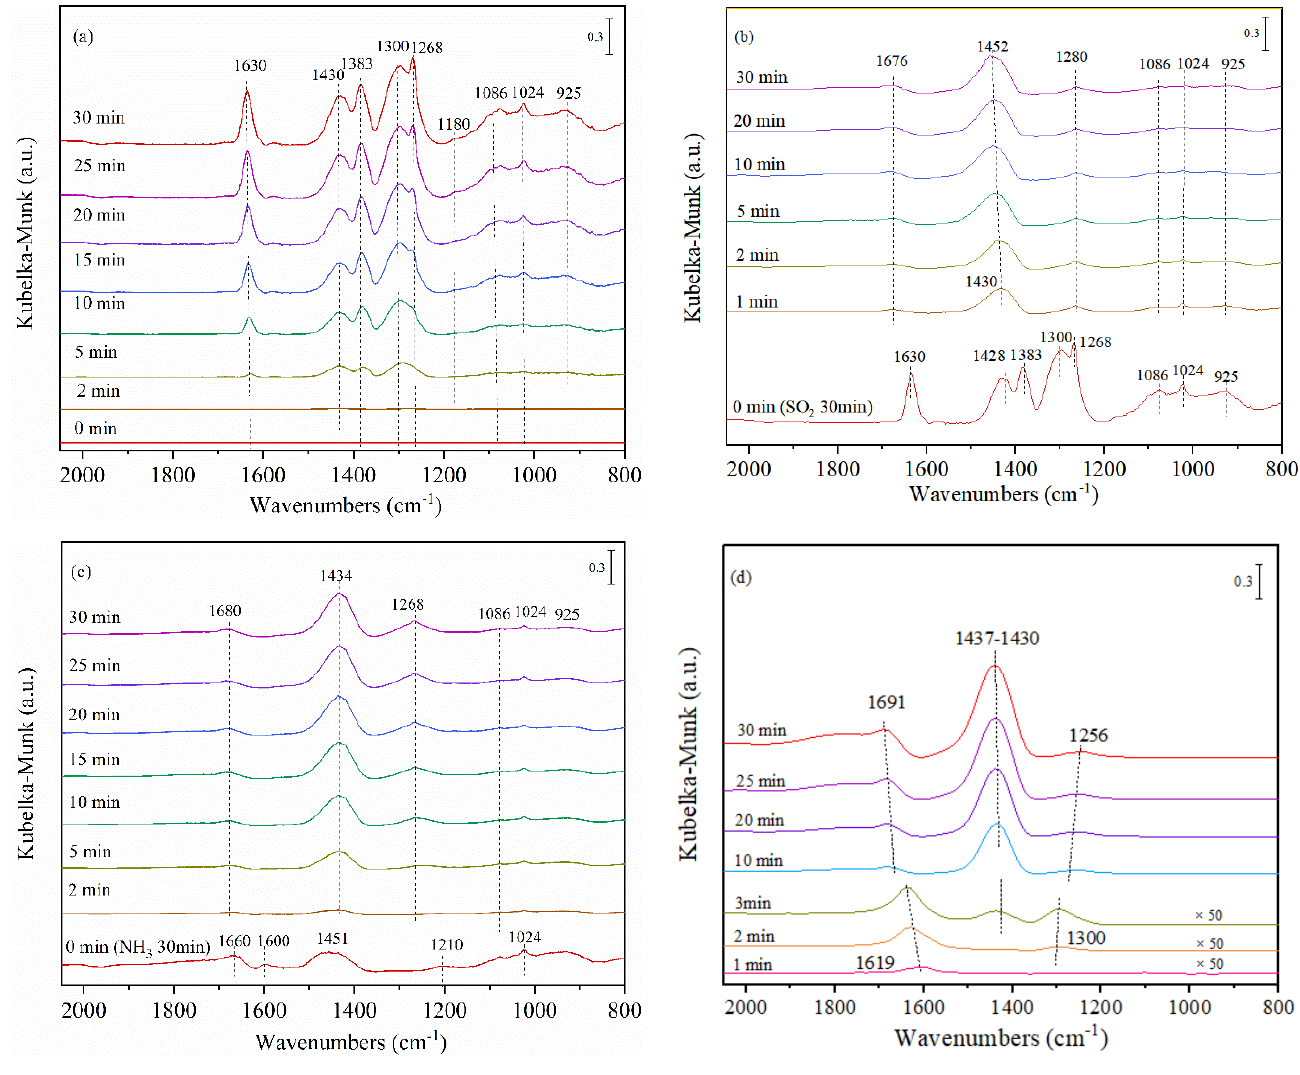
Figure 5. DRIFT spectra of ( a ) the catalyst exposed to SO 2 + O 2 as a function of time, ( b ) the SO 2 + O 2 pretreated catalyst exposed to NH 3 , ( c ) the NH 3 pretreated catalyst exposed to SO 2 + O 2 , and ( d ) the catalyst exposed to NH 3 + SO 2 +O 2 at 100 °C as a function of time.